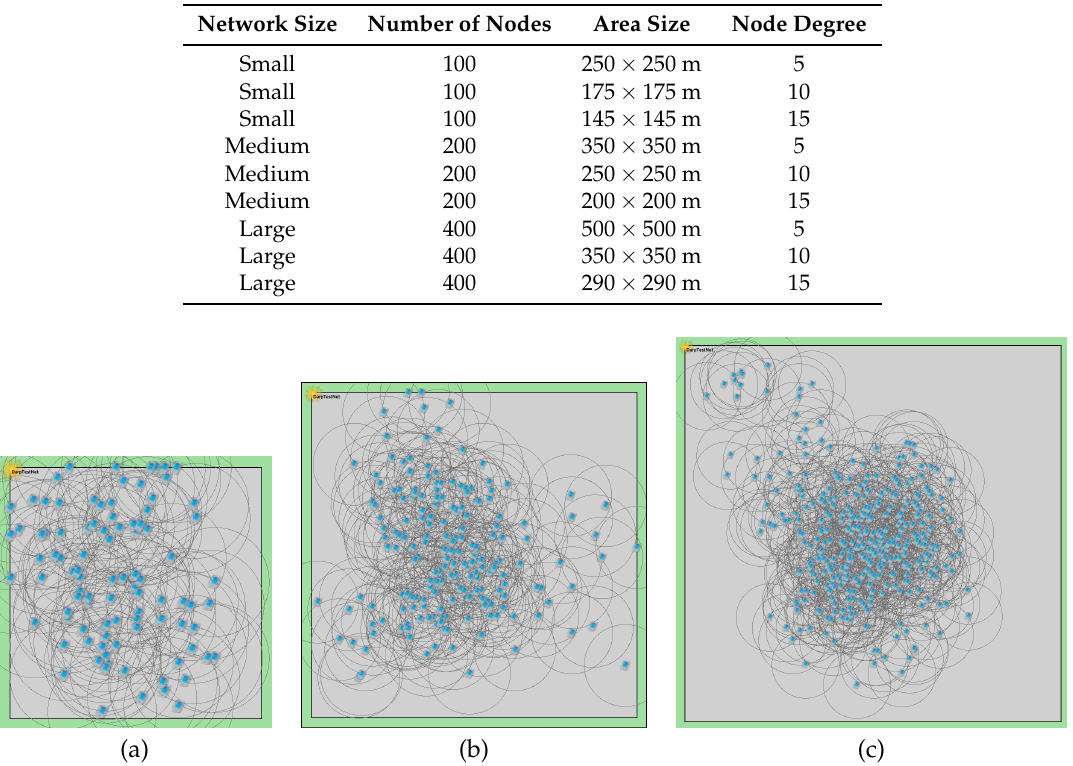
Table 2. Different simulation scenarioes.